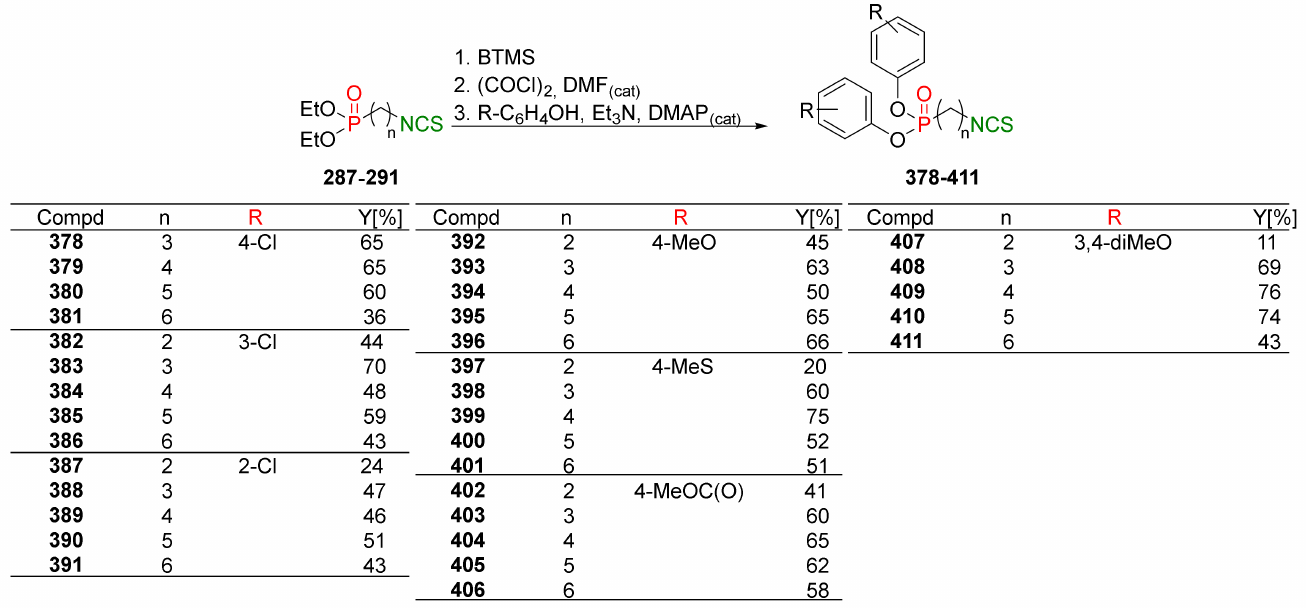
Figure 43. Synthesis of diaryl ω -(isothiocyanato)alkylphosphonates 378 – 411 . Except for antibacterial activity, all P-ITCs were evaluated for antiproliferative ac- tivity against LoVo and LoVo/DX cancer call lines. All compounds presented high an- tiproliferative activity, higher or similar to SFN. The most active was compound 407 (IC 50 = 1.0 ± 0.1 µ M), which was 3 times higher than cytostatic CDDP, and more than 22 times higher than SFN.